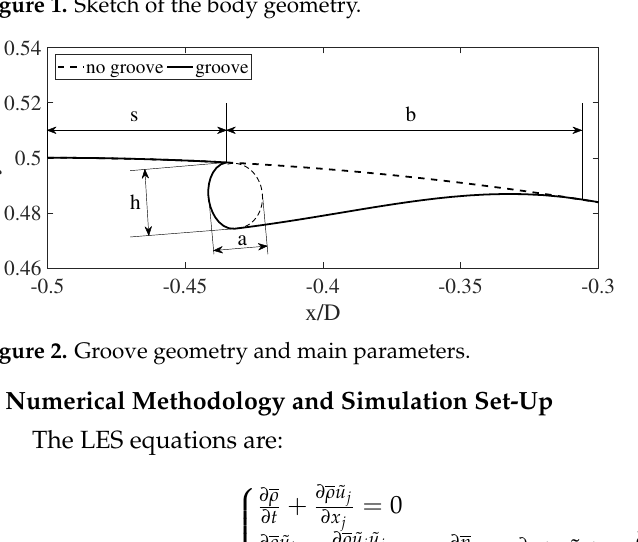
Figure 1. Sketch of the body geometry.